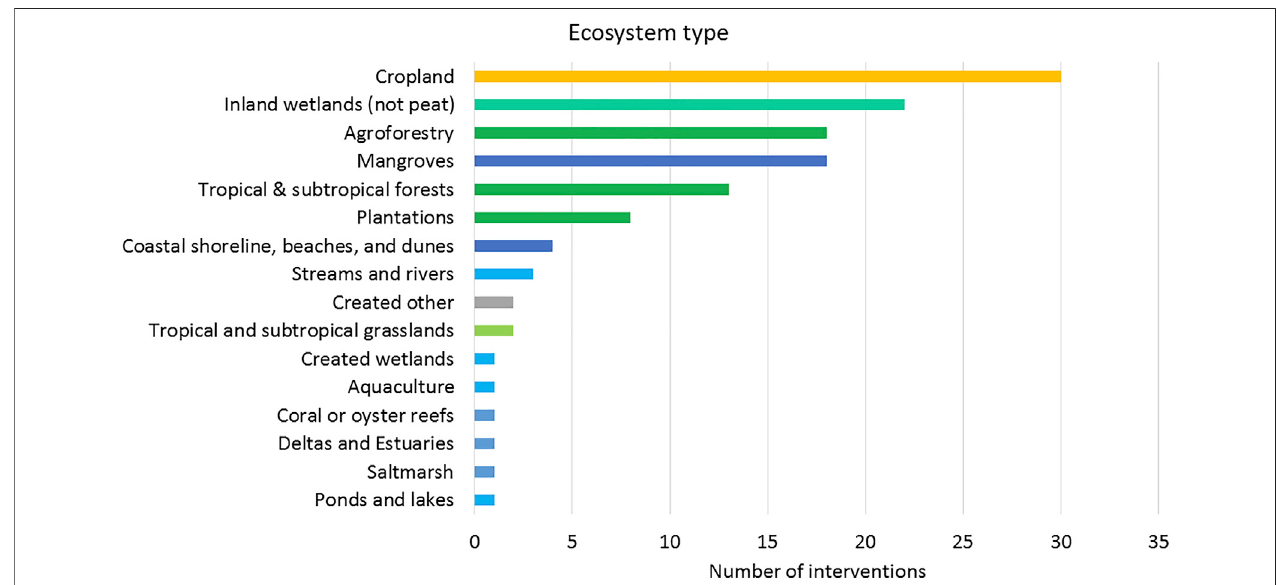
FIGURE 2 | Number of interventions reviewed for each ecosystem